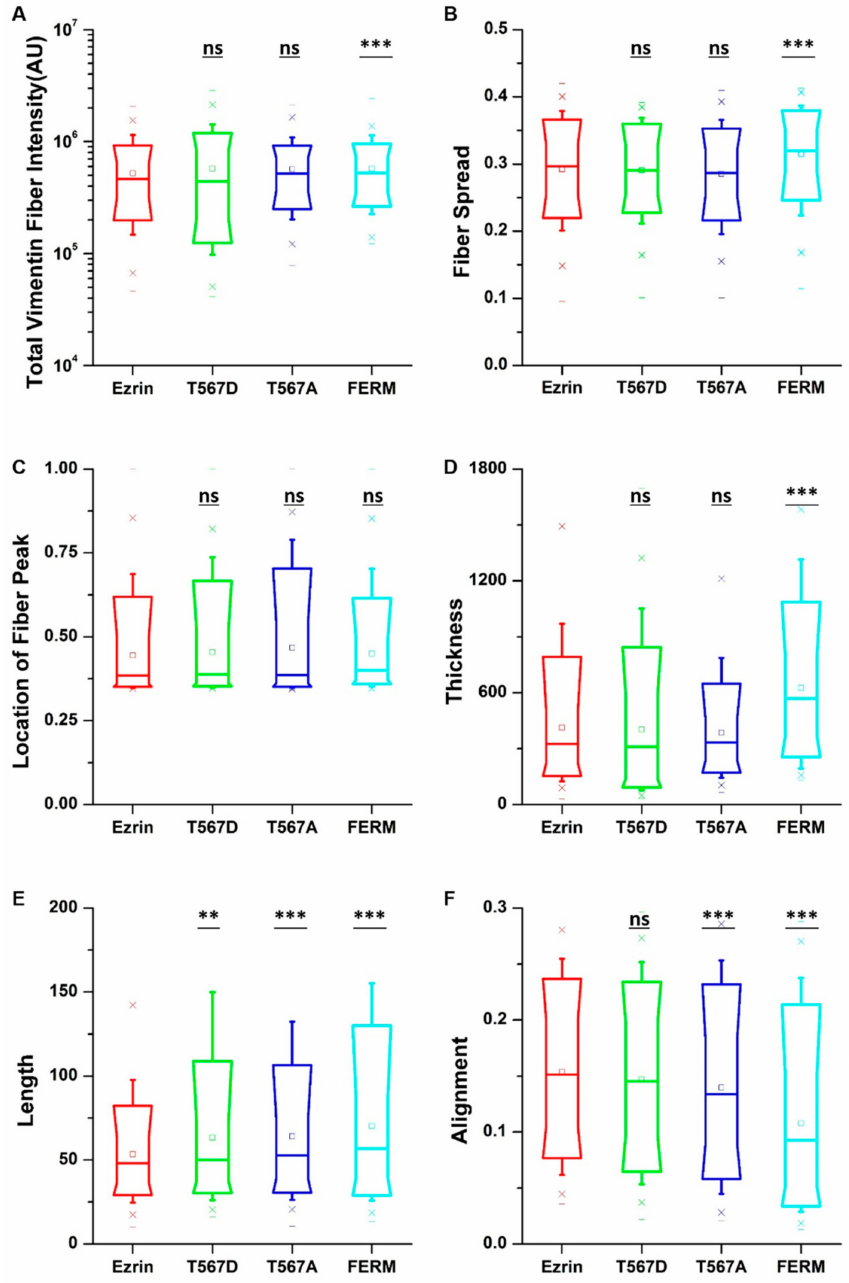
Figure 6. The e ff ect of ezrin mutations on the vimentin cytoskeleton. Box plots show the results of the total vimentin fiber intensity ( A ), fiber spread ( B ), location of the fiber peak ( C ), fiber thickness ( D ), fiber length ( E ), and fiber alignment ( F ). Box plots extend from the 10th to the 90th percentile, whiskers from the 5th to the 95th. A total of n = 585 (ezrin), n = 424 (ezrin T567D), n = 768 (ezrin T567A), and n = 425 (FERM) cells were analyzed from n = 6 repeats. Asterisks indicate a statistical di ff erence (** p < 0.01, *** p < 0.001, obtained using Dunnett’s test against wild-type